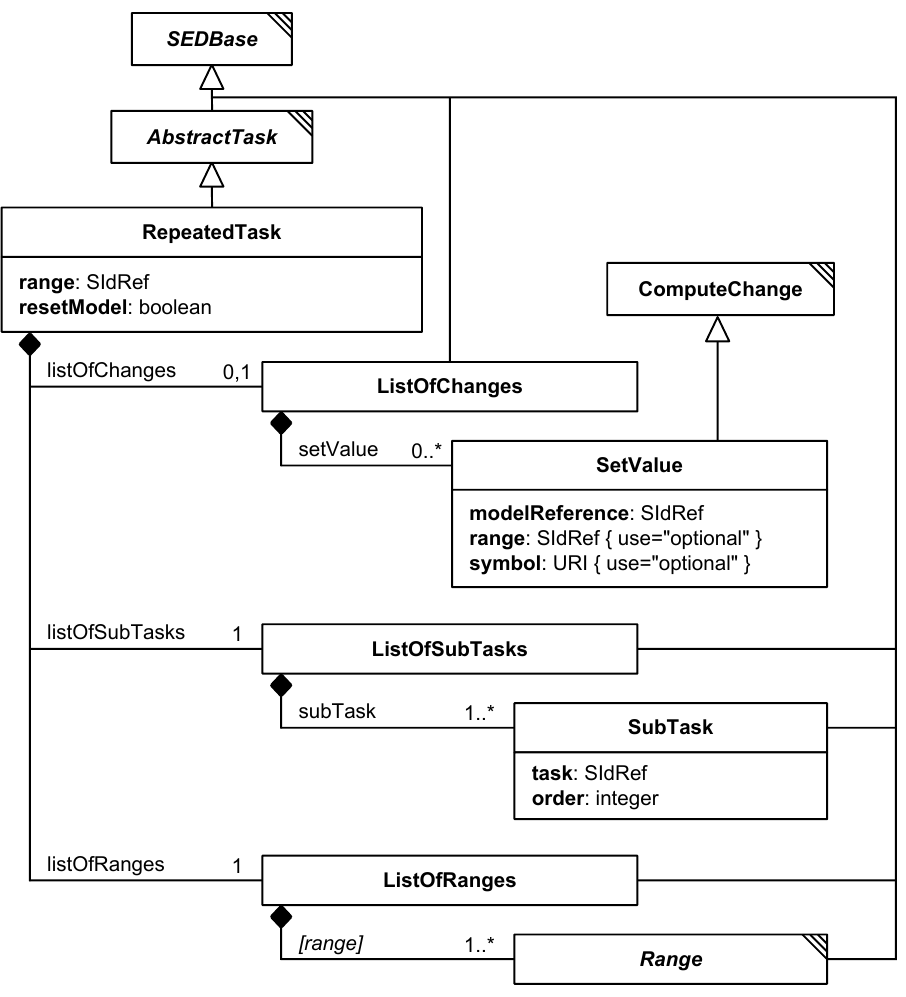
Figure 2.13: The SED-ML RepeatedTask